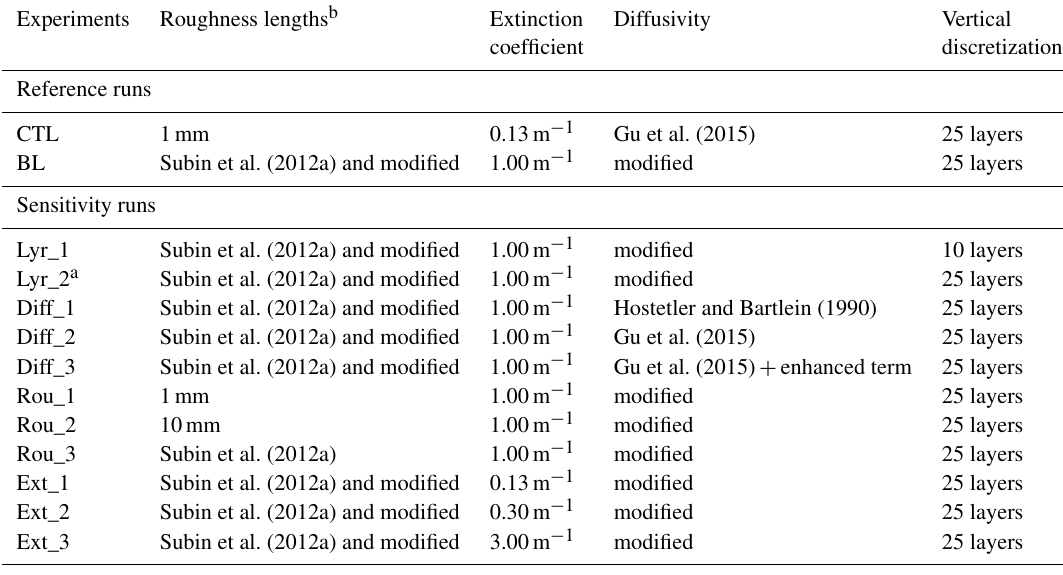
Table 3. An overview of numerical experiments designed to demonstrate sensitivity in WRF-rLake. Experiments